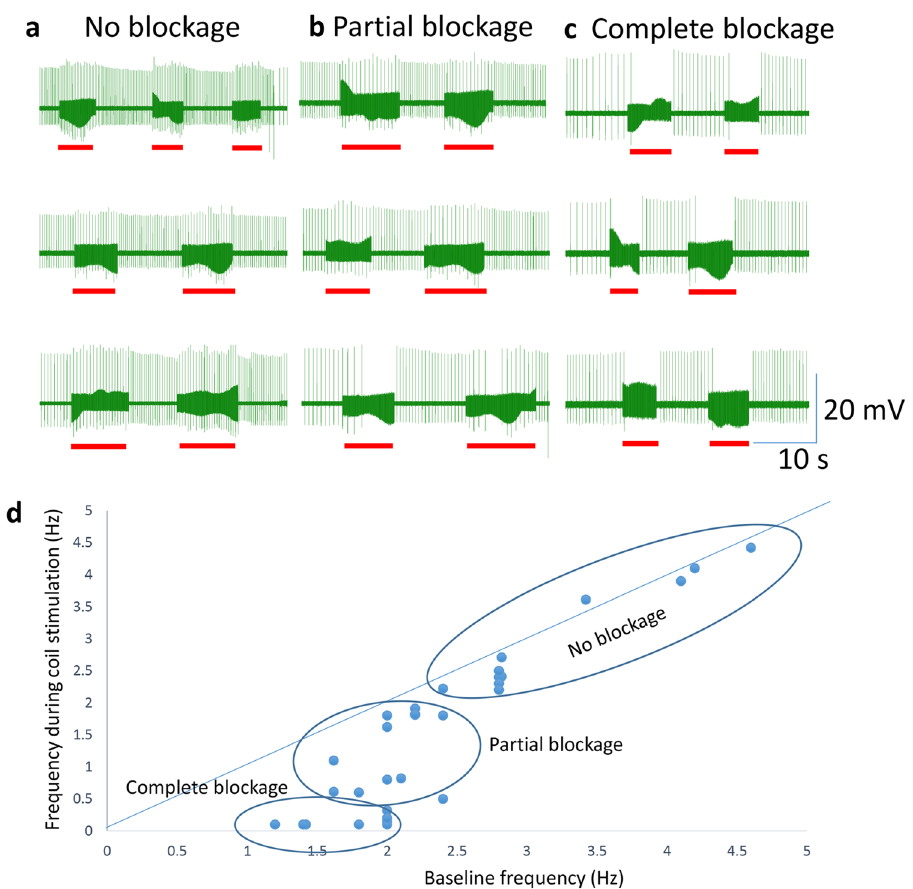
Figure 4. Magnetic blockage of neural activity was dependent on the spontaneous firing frequency in the neuron. ( a ) Magnetic stimulation (400 Hz, red bars) was ineffective when the neuron exhibited high firing rates. ( b ) Magnetic stimulation partially blocked the neuron that was moderately active. ( c ) Magnetic stimulation completely suppressed the neuron whose activity was low. In ( a – c ), three representative traces for the neuron were shown at each activation state. ( d ) Firing frequency of the neuron in baseline recording versus that during magnetic